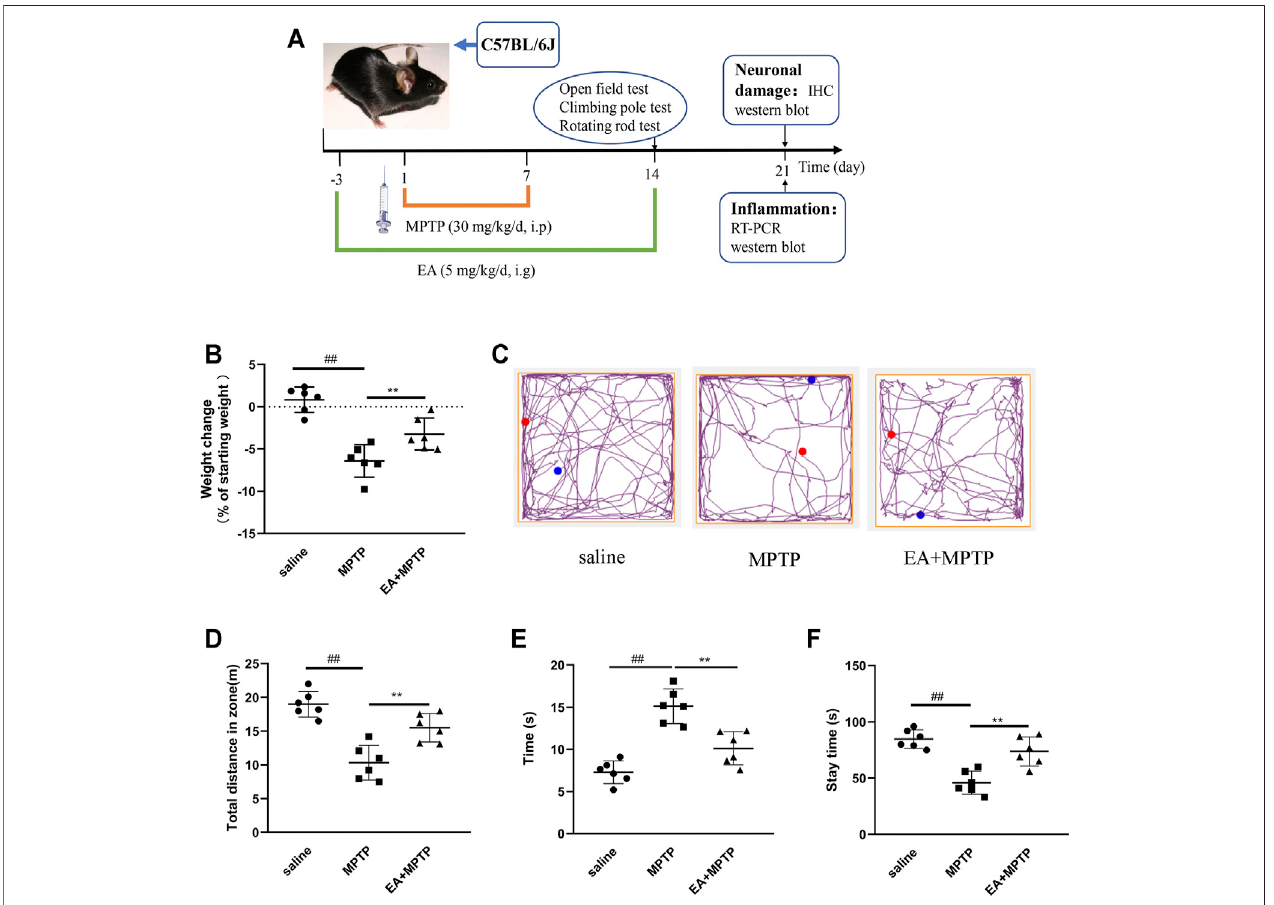
FIGURE6| EAimprovesMPTP-inducedbodyweightlossandlocomotor activitydecreasinginamousemodelofPD.Mice weregivenEA(5 mg/kg)bygavagefor 17 dandMPTP(30 mg/kg)byintraperitonealinjectionfor7 d (A) .ThenweexaminedtheeffectofEAonbodyweightloss (B) ofmiceandthelocomotoractivity via open- fi eld (C,D) , rod climbing (E) , and rod rotating (F) experiments. Results are represented as means ± SD ( n (cid:1) 6). ## p < 0.01 vs. saline group. **p < 0.01 vs. MPTP group.